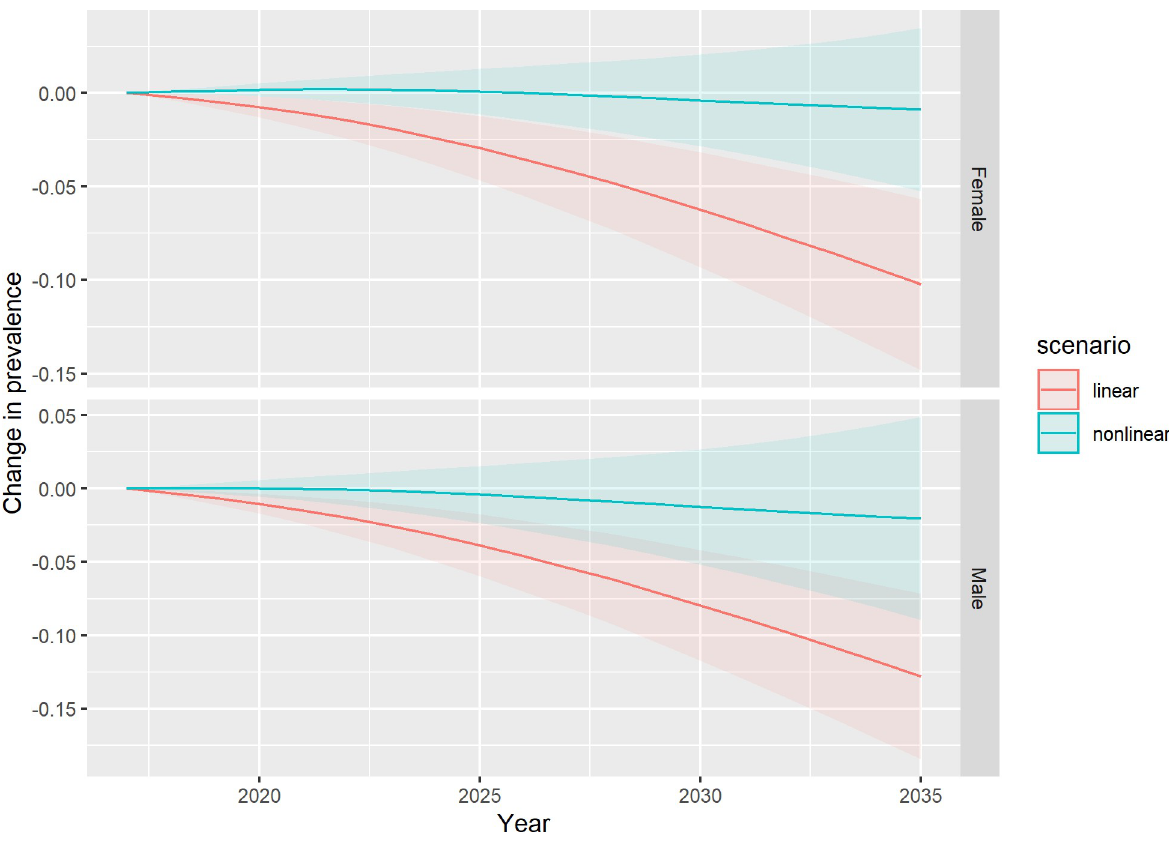
Fig 2. Predicted change in prevalence of the population at increased risk of disease (Overweight, Obese or Very obese).